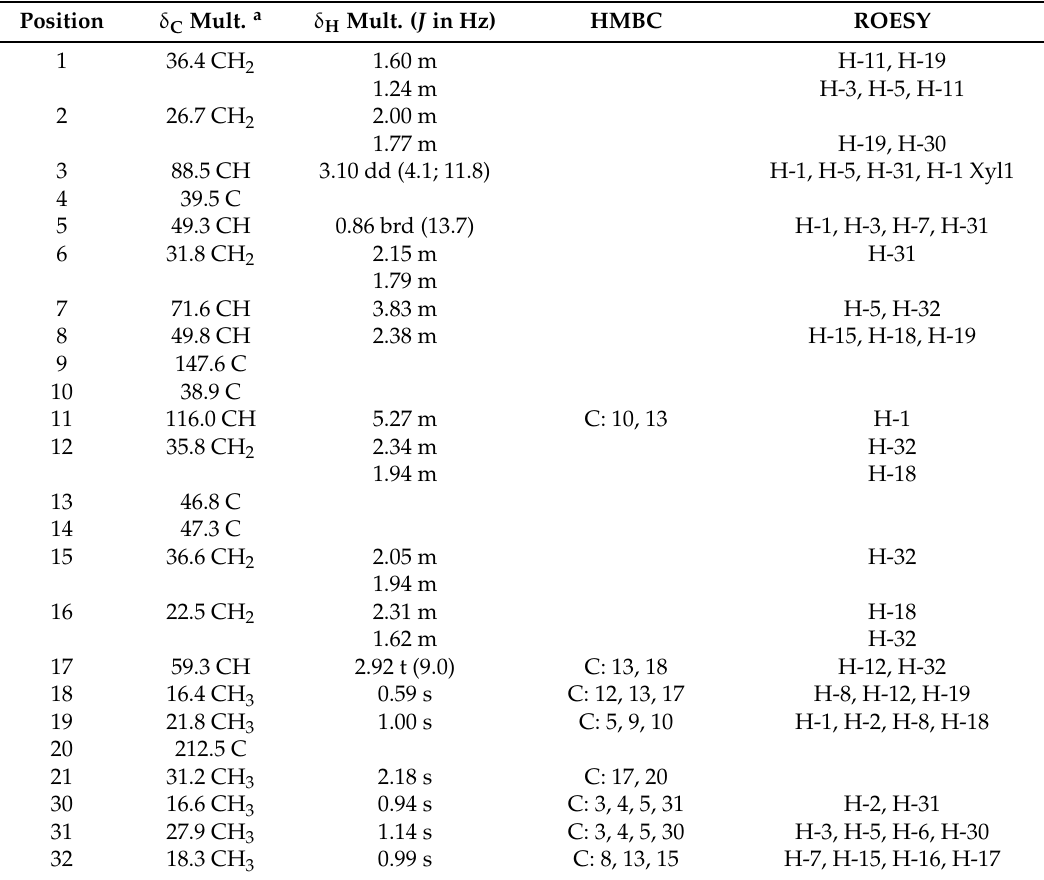
Table 5. NMR spectrosopic data (700 MHz, C 5 D 5 N/D 2 O (4/1 v / v )) of Aglycone Moiety of fallaxoside D 7 ( 4